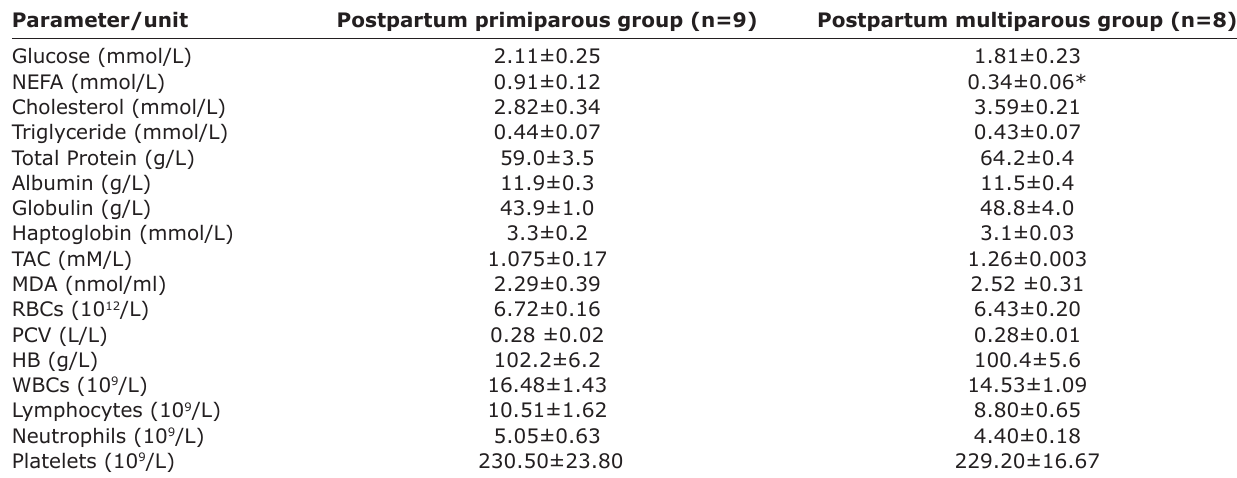
Table-3: Metabolic, oxidative stress, and hematologic profile in postpartum primiparous and multiparous cows.